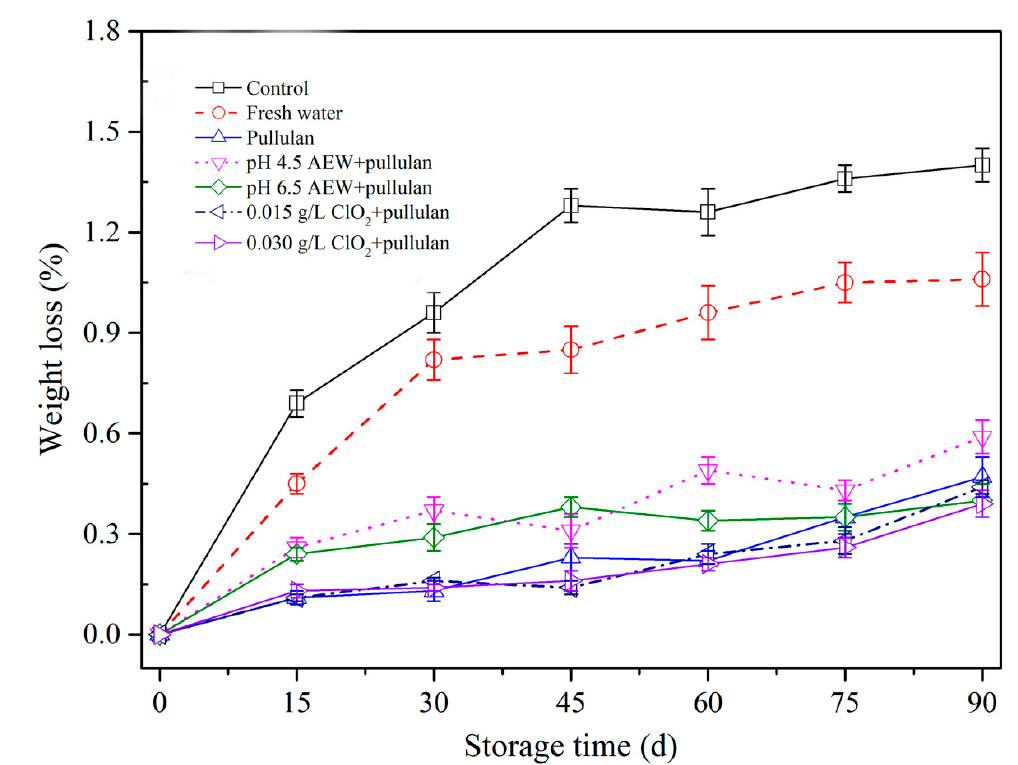
Figure 3. Weight loss of half-shell mussels treated with the control, water, and combined glazing solutions during 90 days of frozen storage.